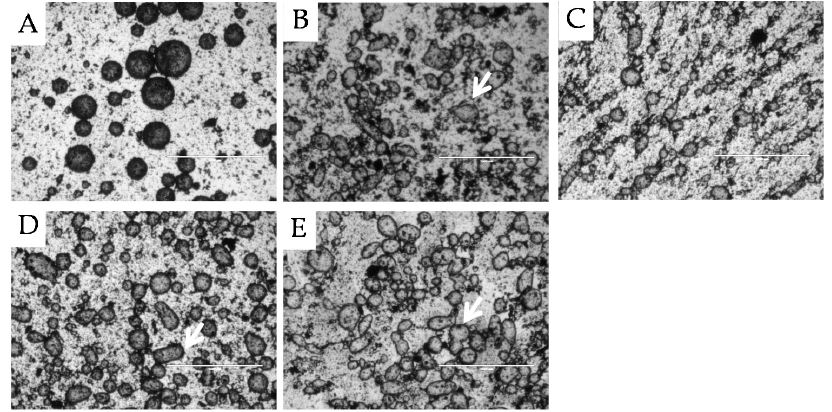
Figure 3. Light micrographs of w/o emulsions with 46% water and stabilised with 8% hydrothermally treated coffee particles with differing oil phase composition acquired after one day of storage at 25 ◦ C. Images are of w/o emulsions with oil phases of ( A ) 100% dodecane; ( B ) 75% dodecane; ( C ) 50% dodecane; ( D ) 25% dodecane; and ( E ) 100% IPM. Scale bar represents 1000 μ m. The arrows indicate the presence of arrested coalescence.